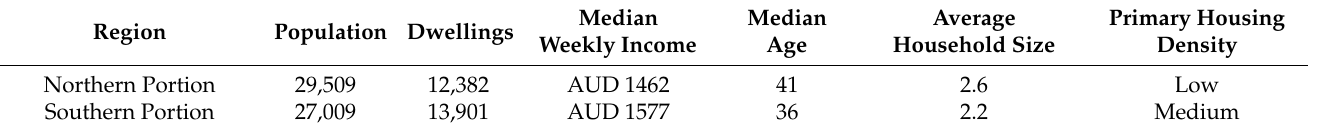
Table 1. Demographic information of areas within the City of Bayswater [35–37].